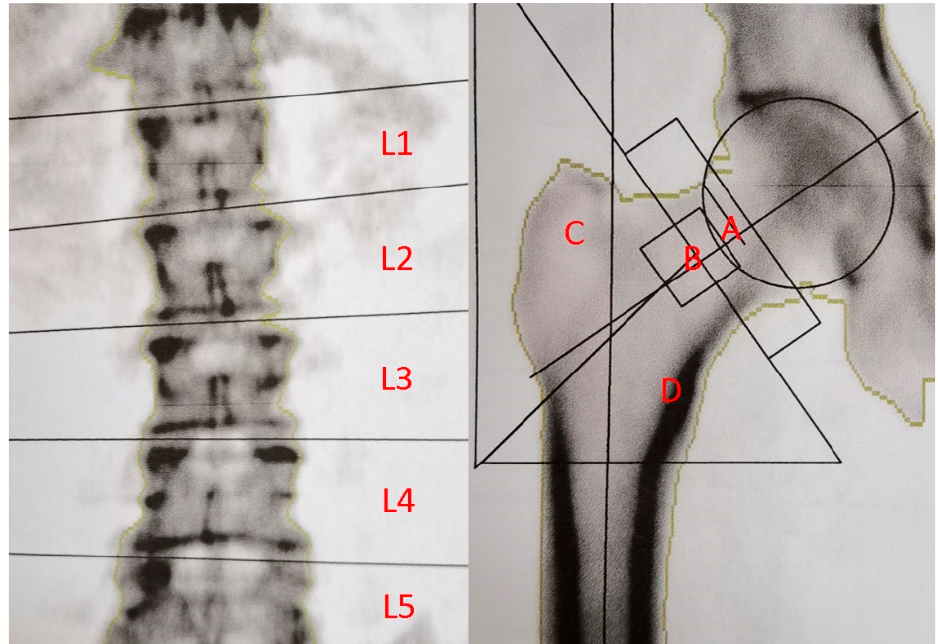
Figure 2. BMD measurement area in the lumbar spine and femur. A: Femoral neck area in BMD. B: Ward’s triangle of the femur area in BMD. C: The greater trochanter of femur area in BMD. D: Femoral shaft area in BMD. BMD is bone mineral density.